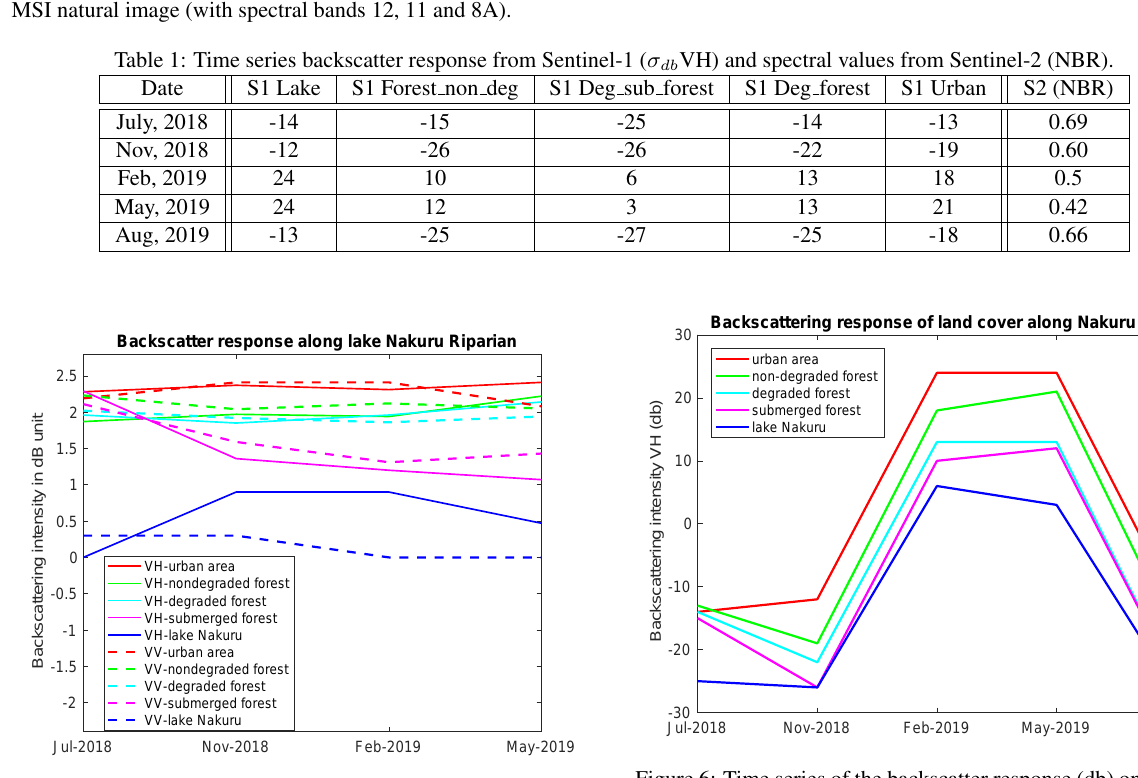
Figure 4: Time series of Sentinel-1 backscatter coefficient σ db (VV) and σ db (VH) on Lake Riparian classes.